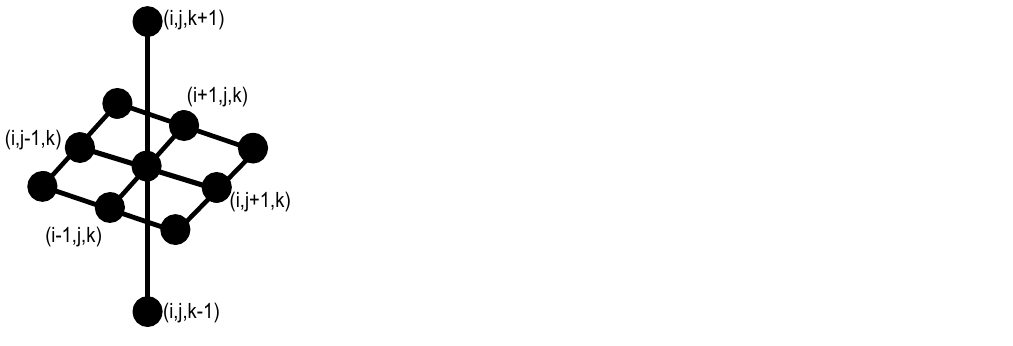
Figure 1. Three-dimensional structuring element B with 11 neighbors. This configuration allows processing 11 pixels into 3 slices. The nine points are taken from the central image, and the two points remaining take information from neighbor images.